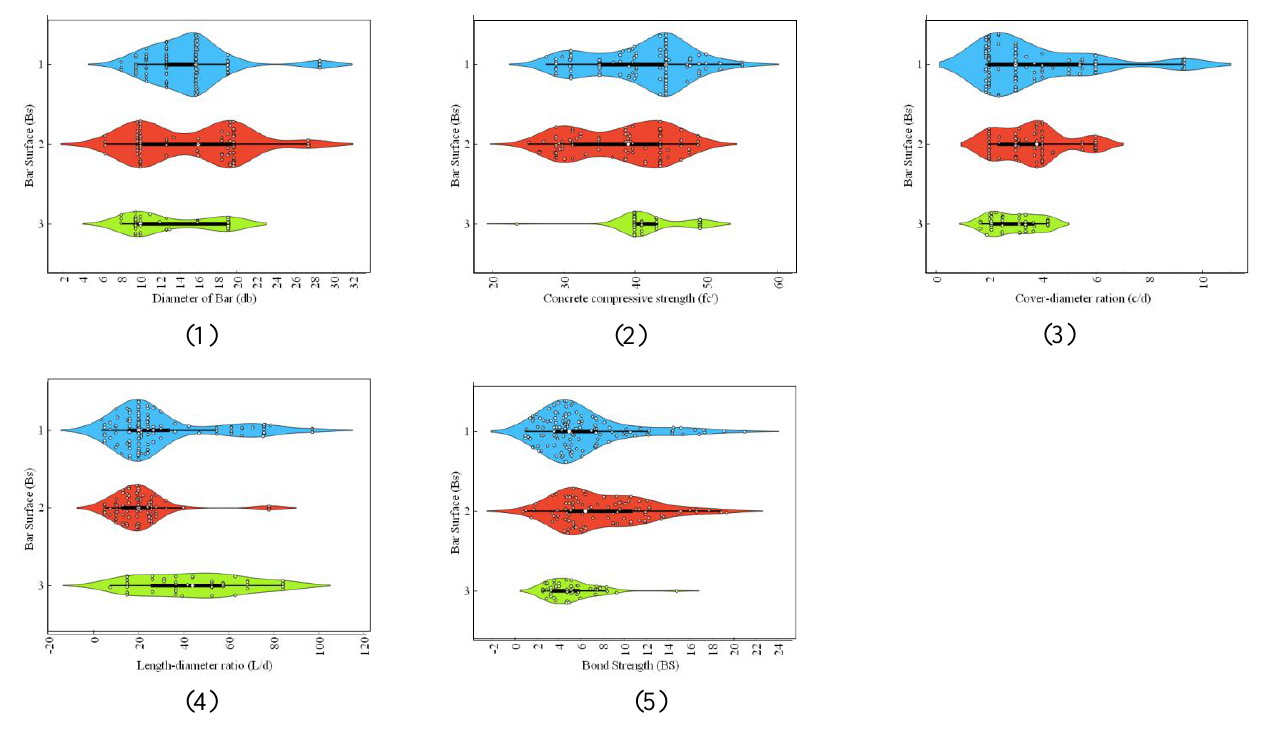
Figure 1. Violin frequency plots input parameters: ( 1 ) diameter of bar ( d b ), ( 2 ) concrete compressive strength ( f c ’ ), ( 3 ) concrete-cover-bar-diameter ratio ( c/d ), ( 4 ) embedment-length-bar-diameter ratio ( l/d ), ( 5 ) bond strength (BS) with respect to the bar surface ( B s ). Different colors shows the voilin plots distinctly for three types of bar surfaces.